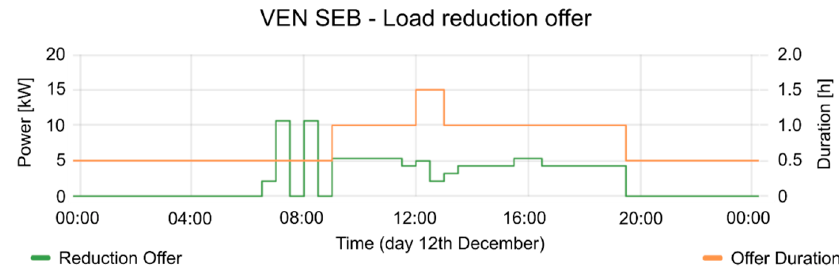
Figure 18. Offers of reduction and their duration for 12 December test.